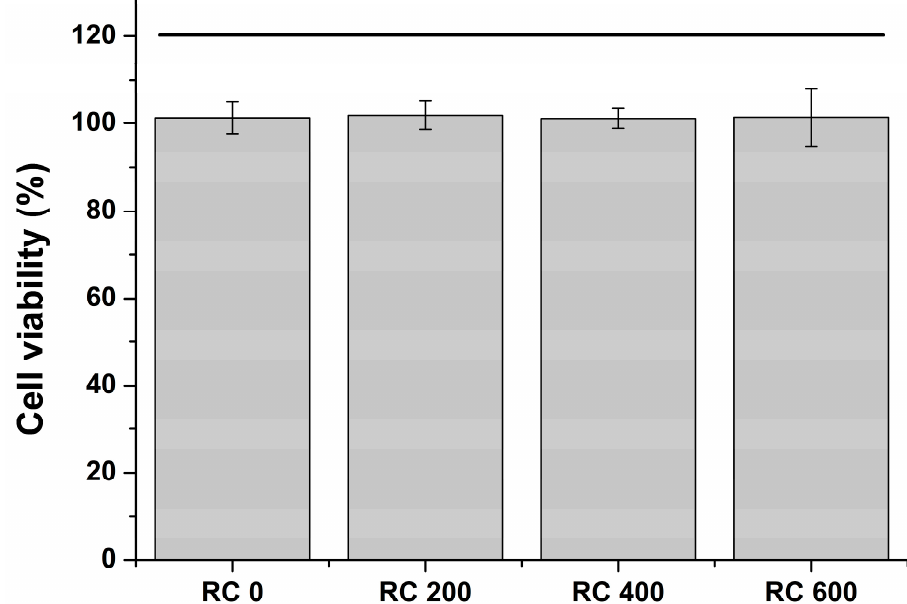
Figure 3. Bar graph showing the cell viability of the extract solutions from the experimental and control groups. Each value shows the average of five measurements, and the error bar indicates the standard deviation of the average. The horizontal bar shows no significant differences among the groups (p > 0.05).